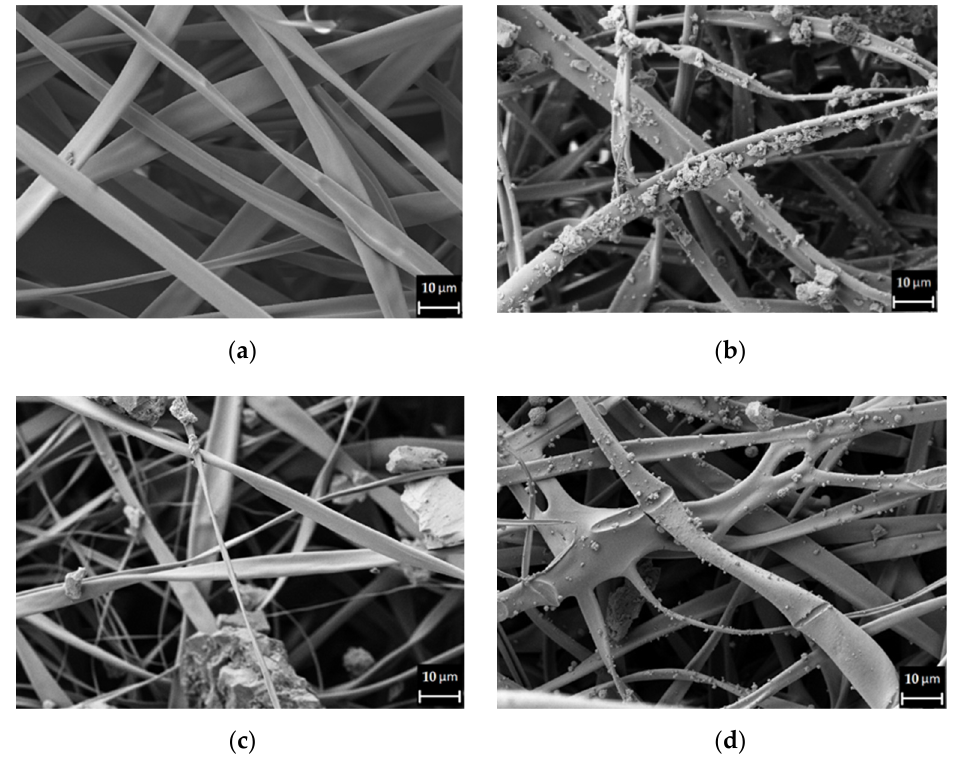
Figure 6. SEM images of the composite filter divided into the four layers of fabrication: ( a ) 1st layer, CA fibres; ( b ) 2nd layer, AC spray; ( c ) 3rd layer, CA fibres; ( d ) 4th layer, TiO 2 spray.